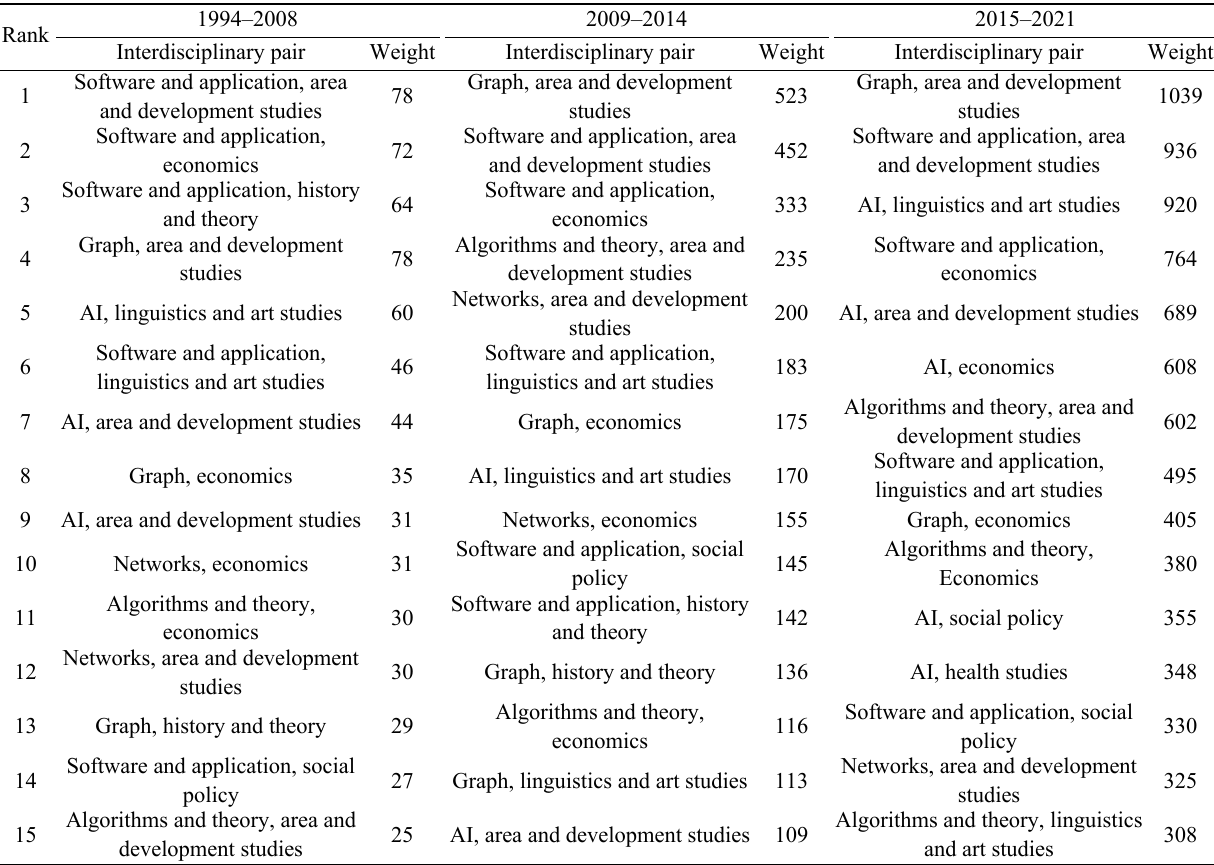
Fig. 8 Interdisciplinary network in different time stages. Table 11 Interdisciplinary pairs with the highest weights in different time